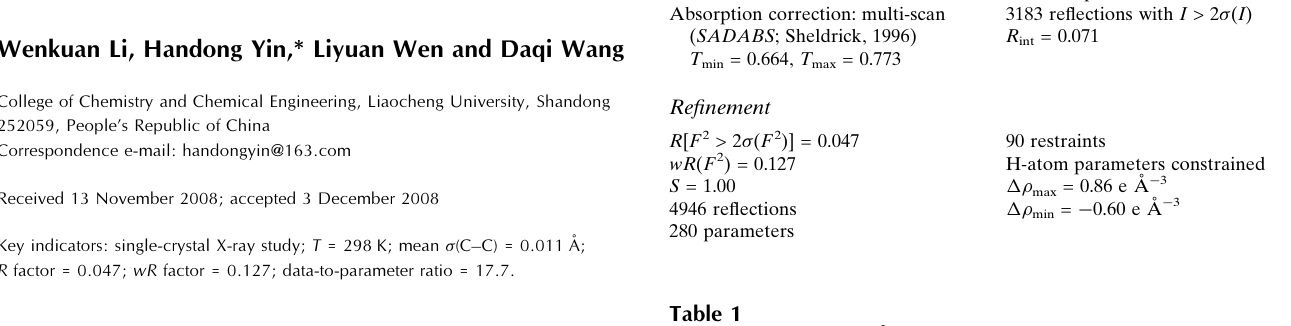
Selected bond lengths (A˚